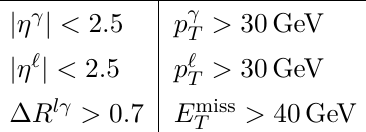
Table 10 . Fiducial cuts imposed for the calculation of differential distributions at 13